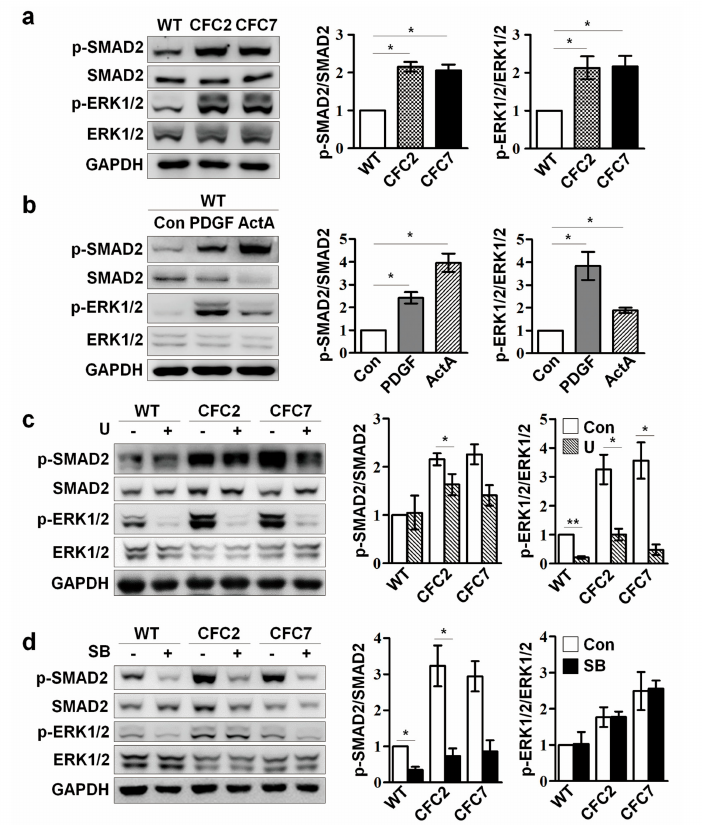
Figure 3. Correlation of ERK signaling and SMAD2 pathway in CFC-MSCs during osteogenic differentiation. ( a ) Activated ERK and SMAD2 pathway in CFC-MSCs during osteogenic differentiation. The levels of p-ERK1/2 and p-SMAD2 were increased in CFC-Obs compared to WT-Obs; ( b ) Regulation of the respective ERK and SMAD2 pathway in the osteogenic process of WT-MSCs. PDGF treatment (10 ng/mL) increased not only p-ERK1/2 but also p-SMAD2, and ActA treatment (50 ng/mL) enhanced not only p-SMAD2 but also p-ERK1/2 in WT-MSCs during osteogenesis; ( c ) Downregulation of both ERK and the SMAD2 pathway in CFC-MSCs by inhibition of ERK signaling. Treatment with U (5 µ M) decreased the levels of p-ERK1/2 and p-SMAD2 in CFC-MSCs during osteogenesis; ( d ) Effects of SMAD2 pathway inhibition in CFC-MSCs during osteogenic differentiation. Treatment with a SMAD2 pathway inhibitor (SB-431542; SB; 5 µ M) decreased p-SMAD2 level, but did not change p-ERK1/2 level in CFC-MSCs during osteogenesis. Proteins were extracted from respective samples at d7 of osteogenic induction and then subjected to western blot. The band intensity of respective proteins was measured using Image J, normalized to that of GAPDH, and expressed as fold changes. Data were expressed as the mean ± SEM (n = 3, biological replicate). * p < 0.05, ** p <